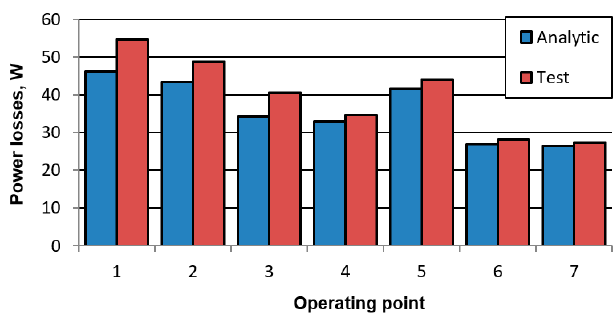
Figure 12. CDM losses by the analytical method and by the experiment for 7 operating points according Table 4 in case of SynRM.